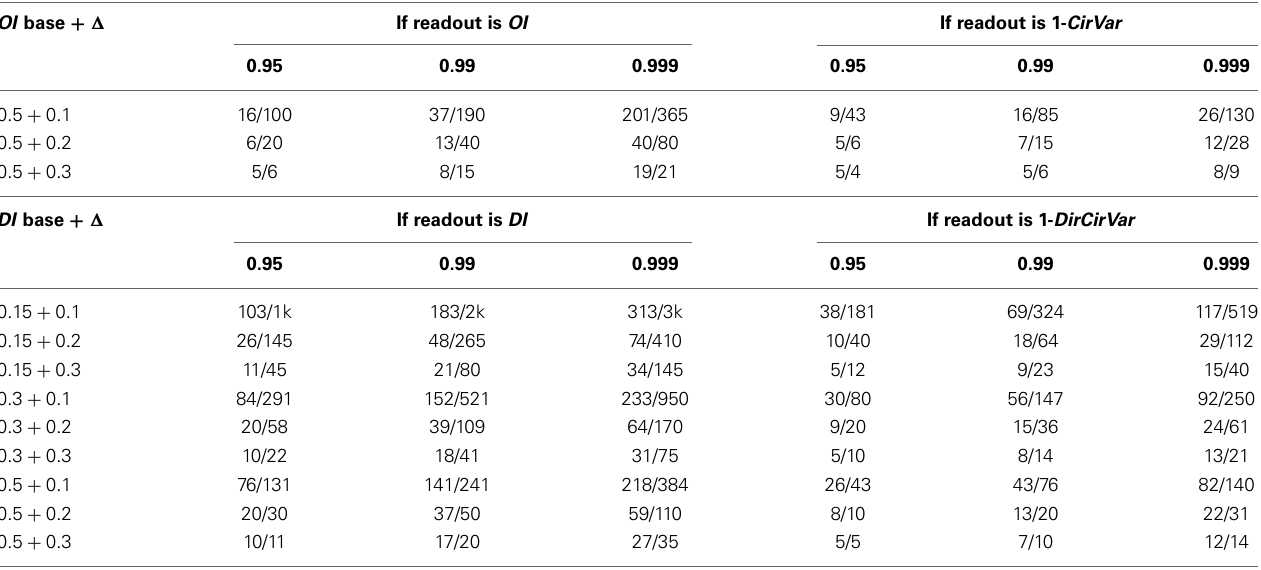
Table 1 | Minimum number of cells per condition that are needed to distinguish underlying orientation or direction selectivity index differences for two noise models.